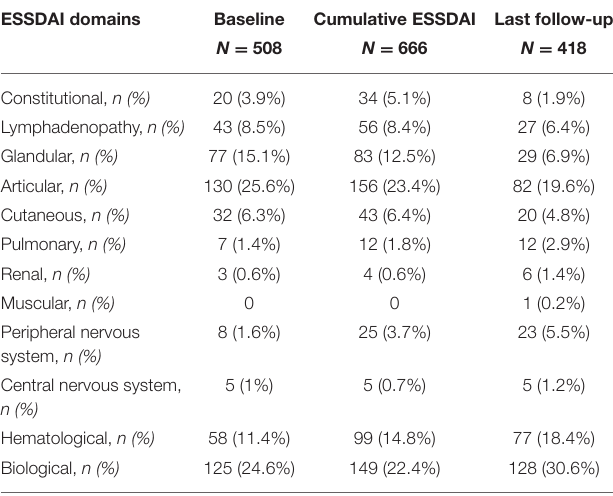
ever during the follow-up, and at last follow-up visit. ESSDAI